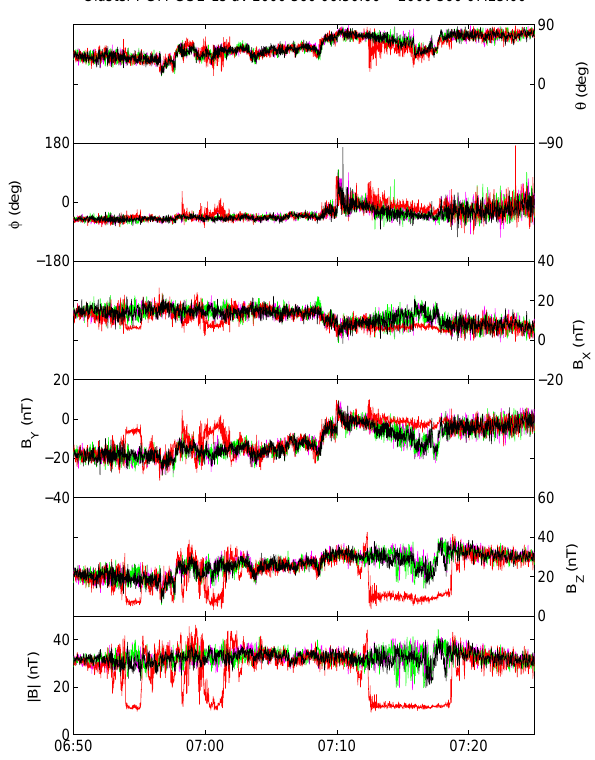
Fig. 12. Cluster magnetic field data during a time when the bow- shock passed repeatedly over spacecraft 2. Traces for each space- craft are shown in a different colour: black, red, green and magenta for spacecraft 1, 2, 3 and 4,